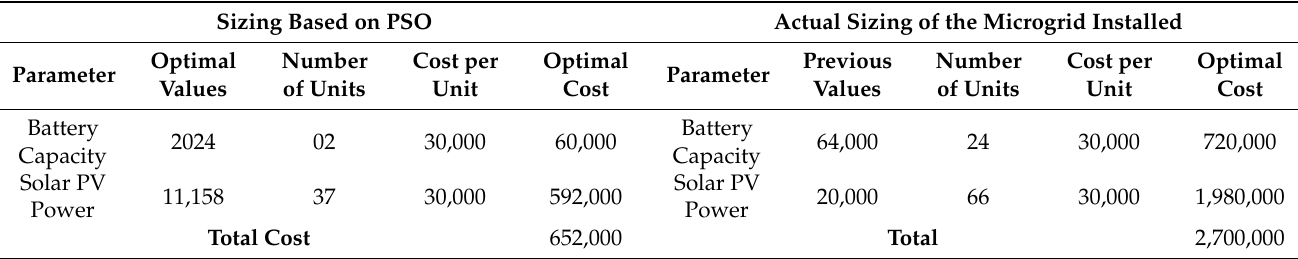
Table 3. Cost comparison of the previous and proposed optimal system at 30